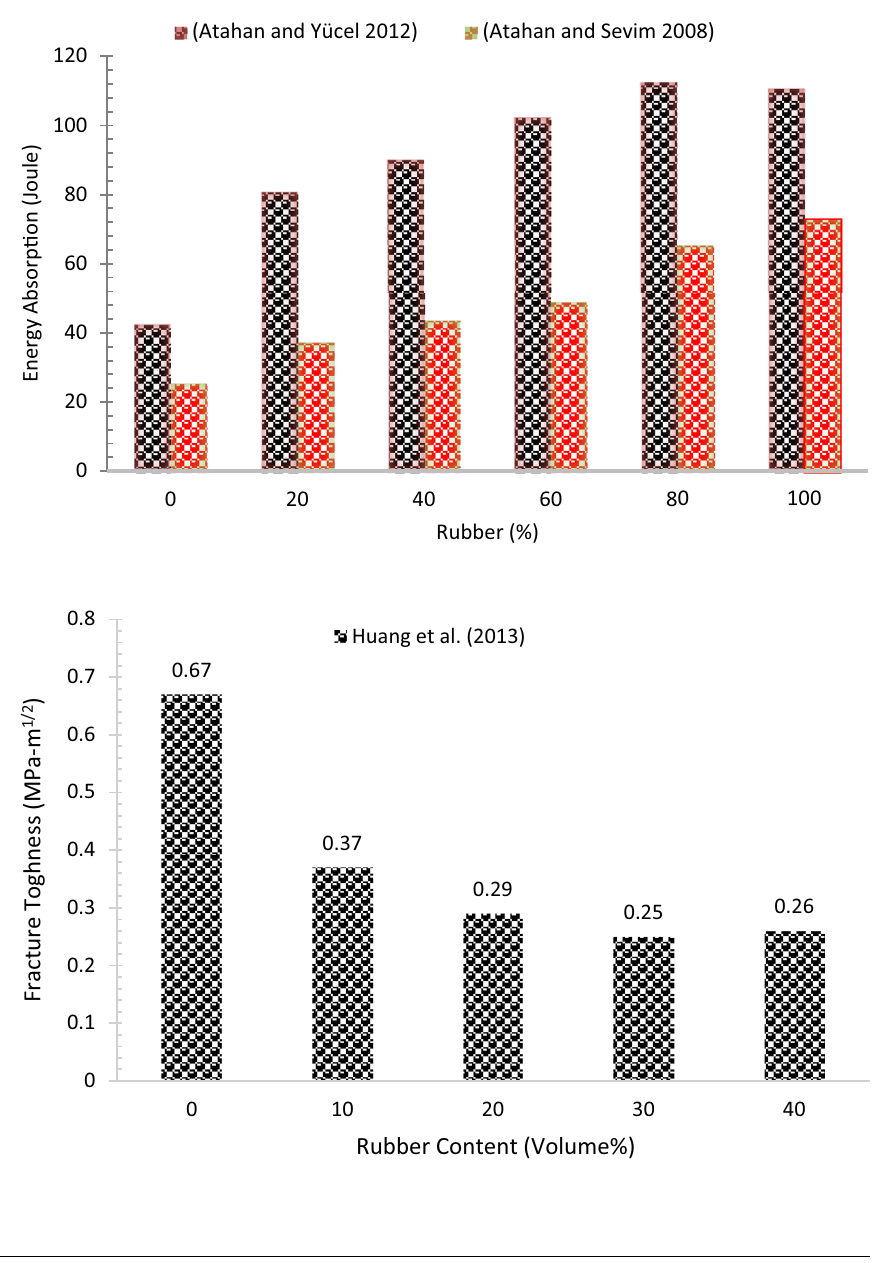
Fig. 25 Energy absorption of concrete containing CR [95, 96]